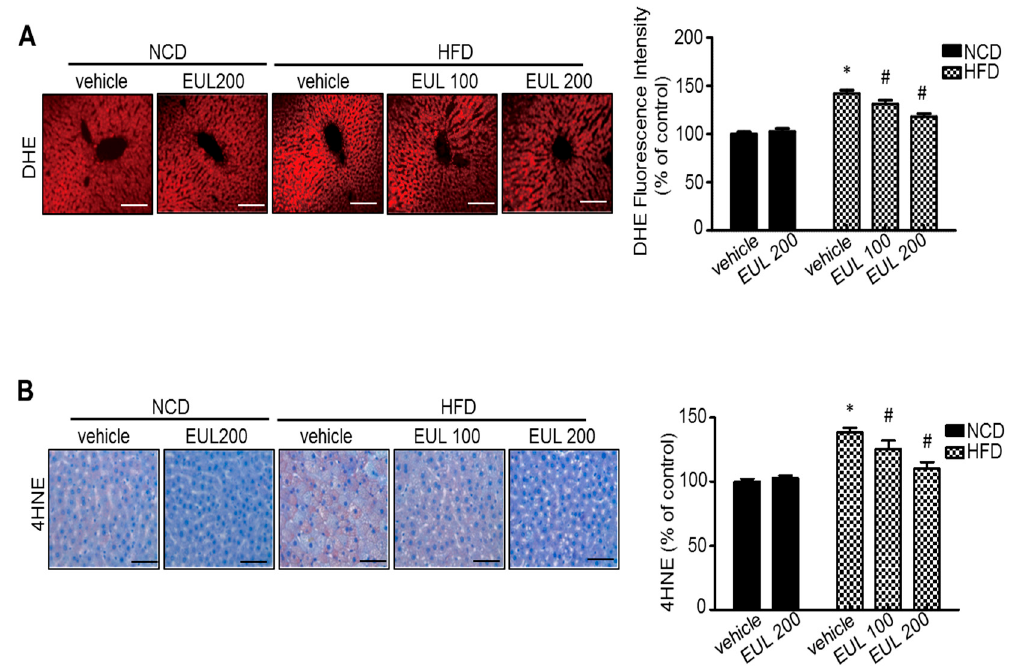
Figure 4. EUL inhibits oxidative stress in hyperlipidemic rats. Experimental scheme. Rats were fed a HFD for 6 weeks, were given 100 mg/kg or 200 mg/kg EUL for 8 weeks, and were then sacrificed. Liver DHE ( A ) and 4-HNE ( B ) levels. DHE is redox-sensitive fluorescent probe. 4-HNE are products of the lipid peroxidation cycle. Liver tissue was collected and was loaded with 5 µM dihydroethidium. Fluorescence images were acquired. Scale bars, 50 µm. Quantification of fluorescence intensity for superoxide levels in the liver. Values are means ± SDs. ( n = 6, * p < 0.05 versus NCD group, # p < 0.05 versus HFD group). NCD, normal chow diet; HFD, high-fat diet; EUL, Eucommia ulmoides leaf extract; and DHE, dihydroethidium.